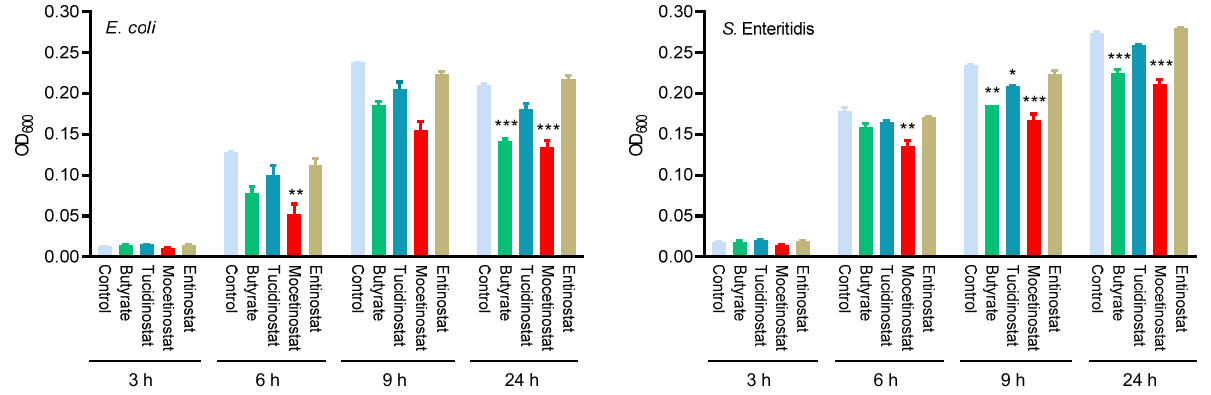
Figure 6. Augmentation of the antibacterial activity of chicken HTC cells by mocetinostat, entinostat, and tucidinostat. Chicken HTCs were stimulated with 10 μ M mocetinostat, entinostat, tucidinostat, or 4 mM butyrate for 24 h, followed by cell lysis and incubation of the cell lysate with Escherichia coli (ATCC 25,922) or Salmonella Enteritidis (ATCC 13,076) for different durations. Bacterial turbidity was measured at OD 600 as an indication of bacterial growth. The results are means ± SEM of two independent experiments. One-way ANOVA was performed, followed by Dunnett’s test. * p < 0.05, ** p < 0.01, and *** p < 0.001 (relative to the unstimulated control at each time point).